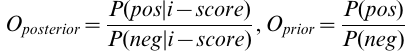
Figure S1 Three types of known DDIs curated in DrugBank. ( A ) Classification of DDIs in DrugBank using a semi-automatic text mining method. ( B ) Percentage of three types of known DDIs curated in DrugBank. Figure S2 ROC curves to compare the prediction performance of various scoring methods. ( A ) GSP DDIs from DrugBank known DDIs. ( B ) GSP DDIs from STITCH DDIs with medium text mining confidence score. ( C ) GSP DDIs from STITCH DDIs with medium text mining confidence score to evaluate novel predictions by each scoring method, which excluded the known DDIs in DrugBank. ( D ) GSP DDIs from DrugBank PD DDIs and GSN DDIs randomly selected 5-times as large as the positive set (Materials and Methods). Figure S3 Additional case studies. ( A ) Atenolol and Meperidine and ( B ) Mirtazapine and Propranolol. The figure legend is the same as those in Figure 4. Table S1 List of drug pairs with LR (S-score and P-score) . 2. (XLSX) Text S1 Appendix with detailed comparison with the recently published methods and discussion on additional case studies of novel PD DDIs